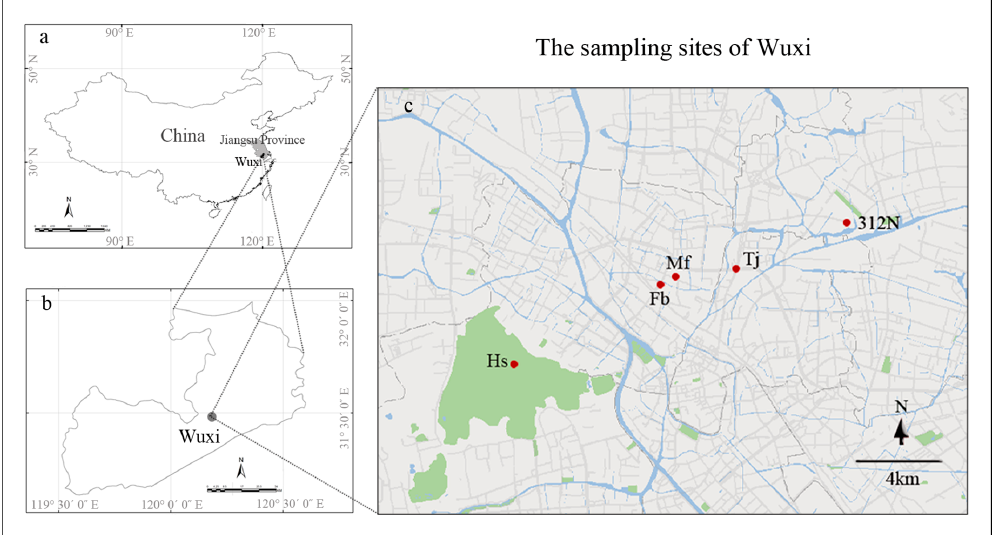
Figure 1. Location of Wuxi in China ( a ); location of study area in Wuxi ( b ); and a map of Wuxi showing the five monitoring sites: four roads (Mf: Minfeng Road, Fb: Fengbin Road, 312N: 312 National Road, Tj: Tongjiang Avenue) and a control site (Hs: Huishan) ( c ).